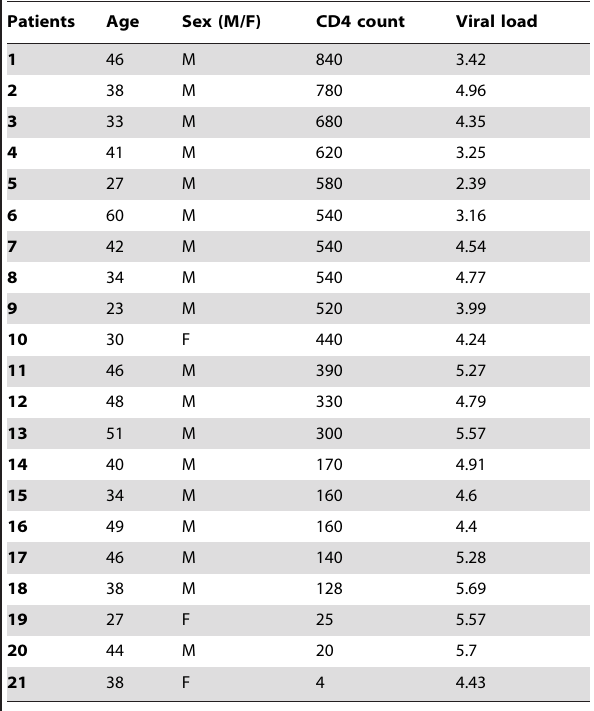
Table 1. Clinical data.